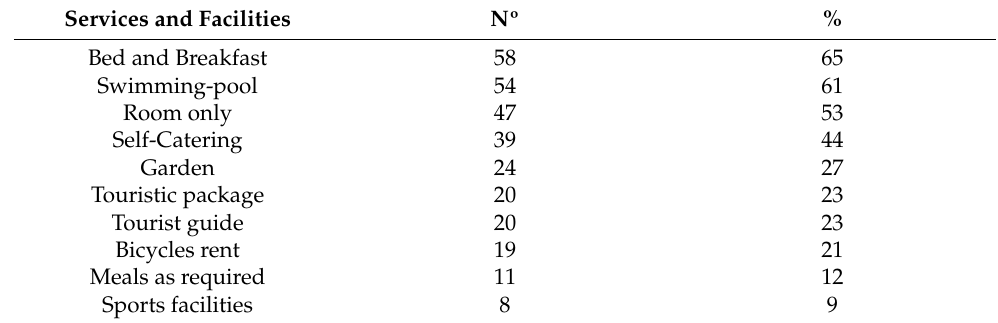
Table 5. Main lodging